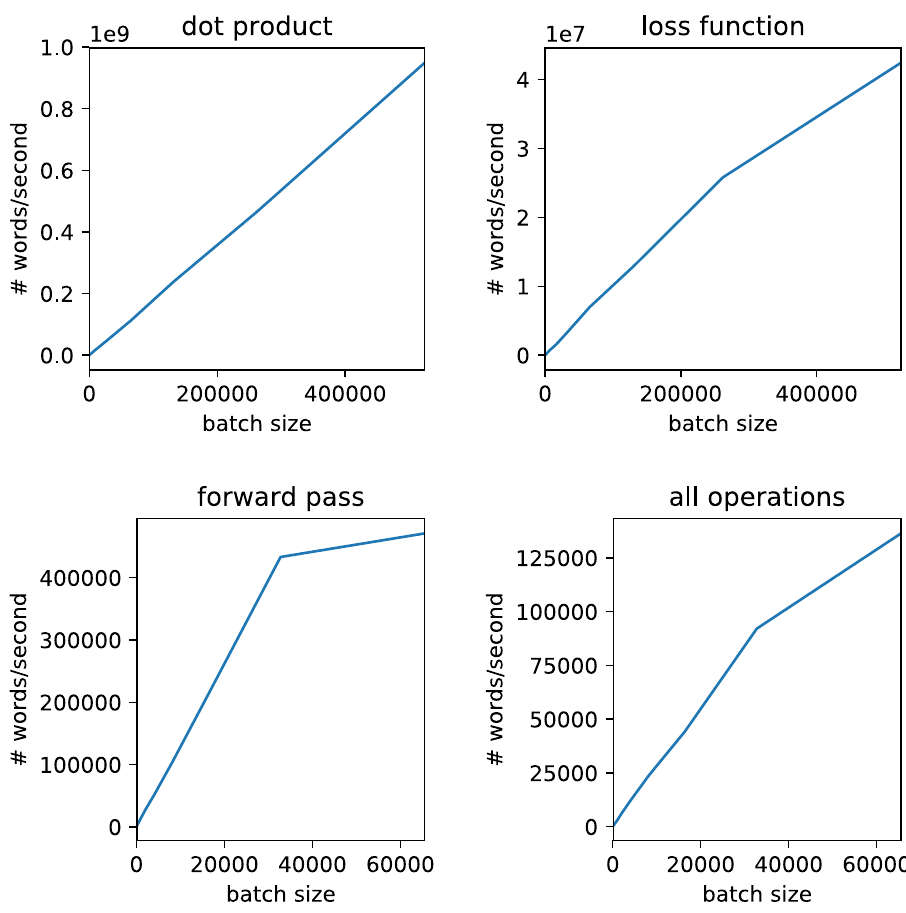
Fig. 3 Number of words/sec- ond with different batch sizes. Dot product Calculate the dot product of two input matrices directly using CuPy. Loss func- tion Calculate the loss of two input matrices directly using CuPy. Forward pass Calculate the loss of a batch of word pairs using Chainer. All operations Train the full model using Chainer. Note that for forward pass, the scaling results are not linear when batch size is larger than 32,768. This is due to the saturation of GPU utilization